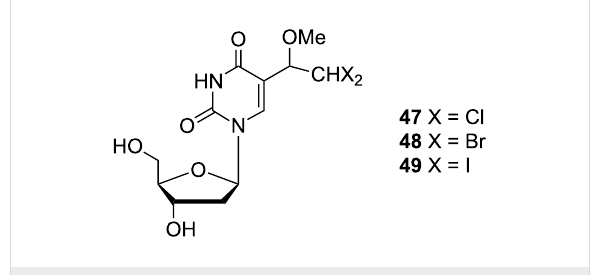
Figure 13: 5-(1-Methoxy-2,2-dihaloethyl)-2'-deoxyuridines 47 – 49